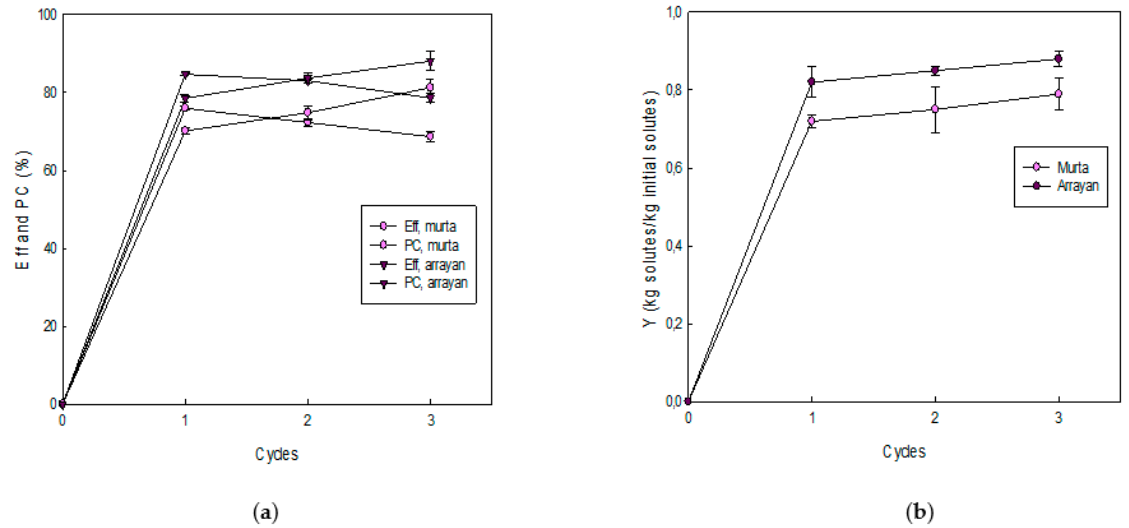
Figure 4. Process parameters at each CBFC cycle: ( a ) efficiency and percentage of concentrate and ( b ) solute yield.